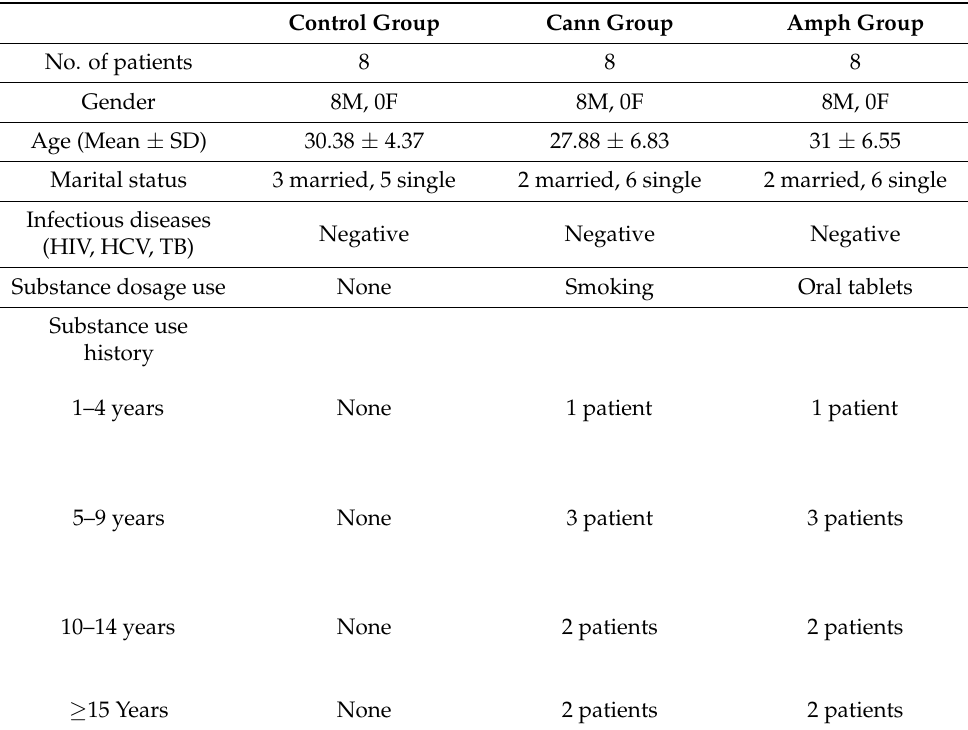
Table 1. Clinical and demographic information of participants enrolled in the study. Age is expressed as mean ± SD. Cann, cannabis. Amph, amphetamine. HIV, human immunodeficiency virus. HPC, hepatitis C virus. TB, tuberculosis. F, female. M, male. Control Group Cann Group Amph Group No. of patients